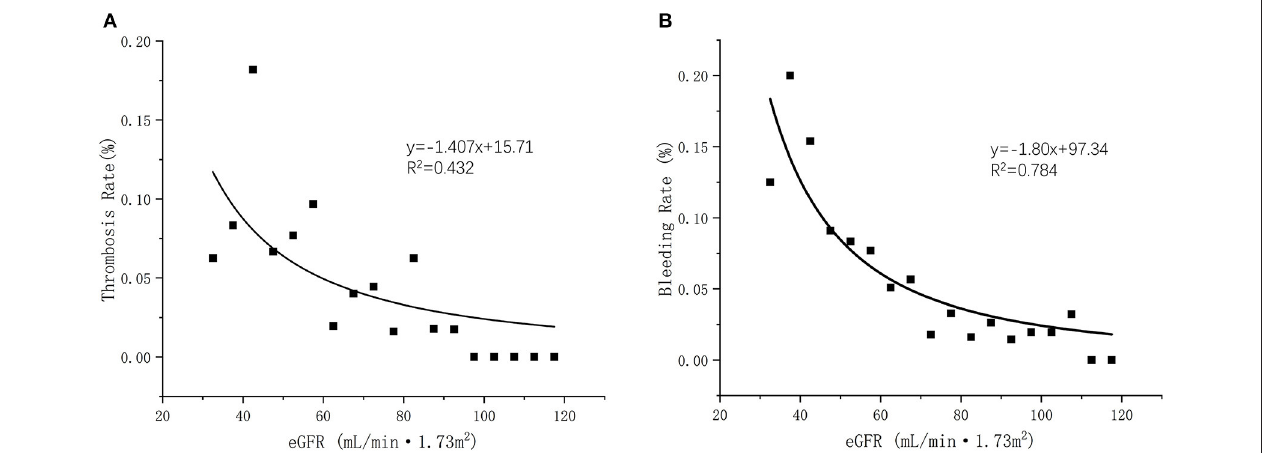
FIGURE 5 | (A) Linear regression of eGFR and thrombosis occurrent rate ( R 2 = 0.432); (B) Linear regression of eGFR and bleeding occurrent rate ( R 2 =